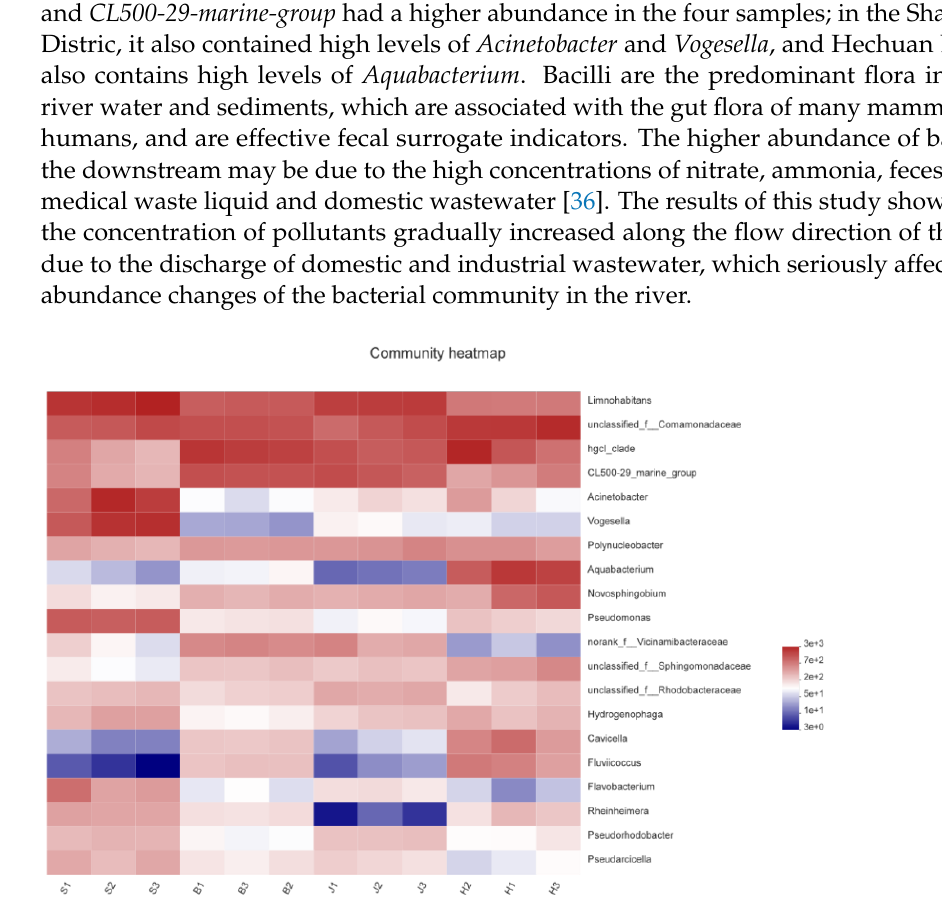
Figure 5 . Heatmap